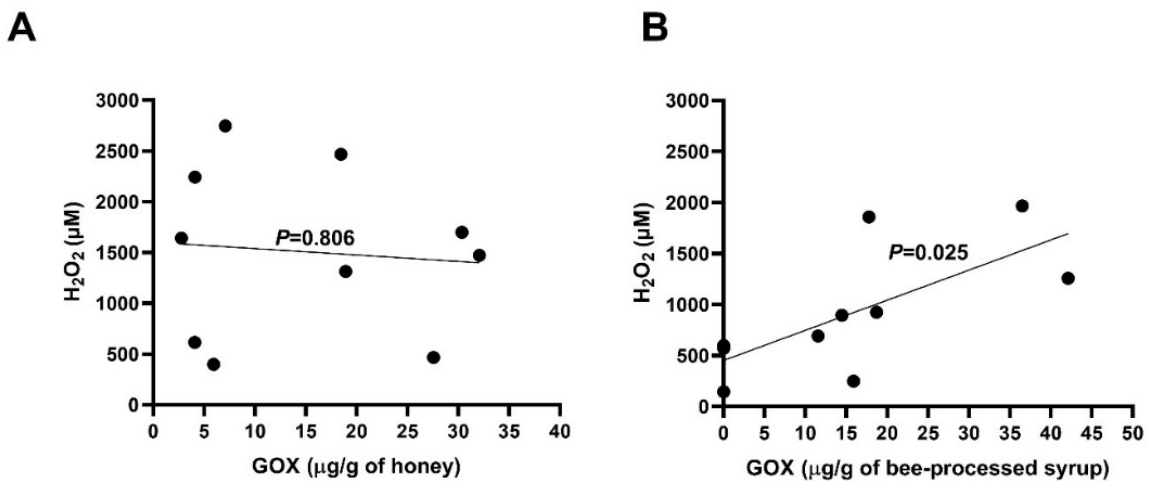
Figure 4. Correlation between the content of GOX and H 2 O 2 production capacity in ( A ) raw honey samples and ( B ) bee-processed syrups. A Pearson correlation test was used for analysis. * P < 0.05 (Pearson’s test).